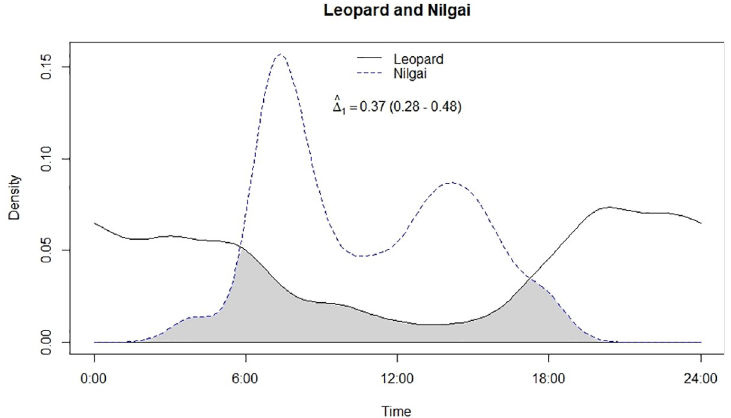
Fig 6. Temporal overlap between leopard and nilgai.